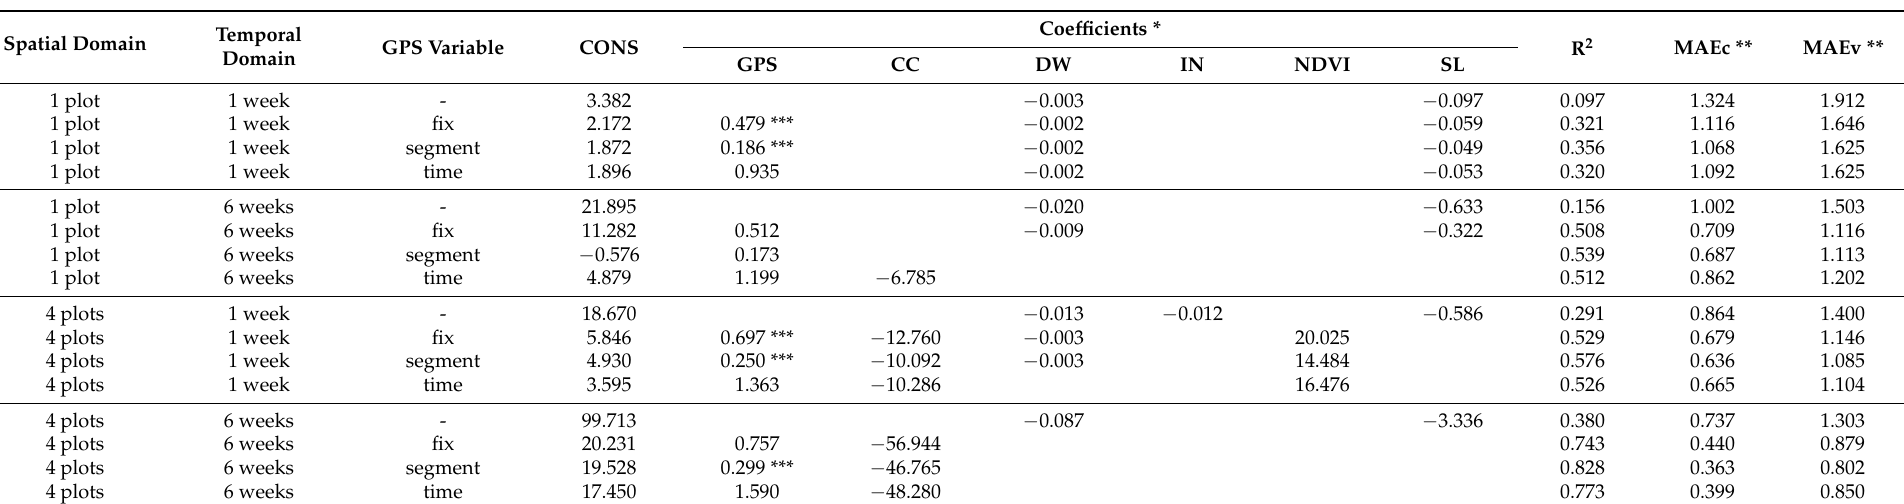
Table 2. Prediction models validated in the temporal